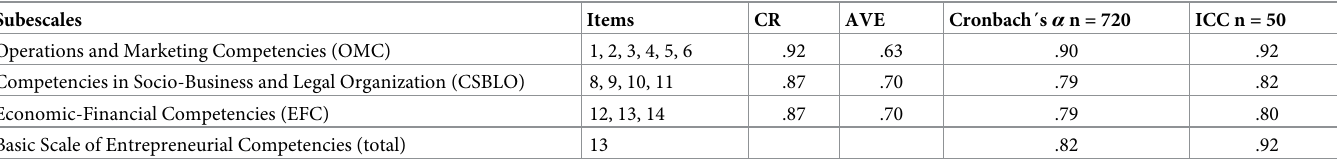
Table 6. Reliability and validity for the BSEC and its subescales.